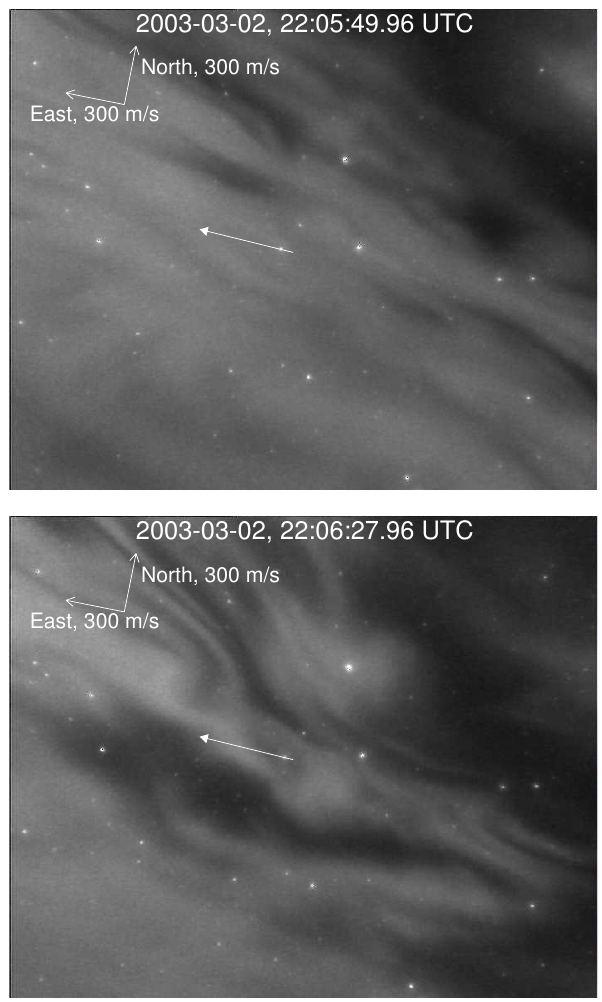
Fig. 4. Two images from event 03C, about 0.5 s apart, showing the black aurora in an on (upper image) and off (lower image) phase of the pulsating aurora